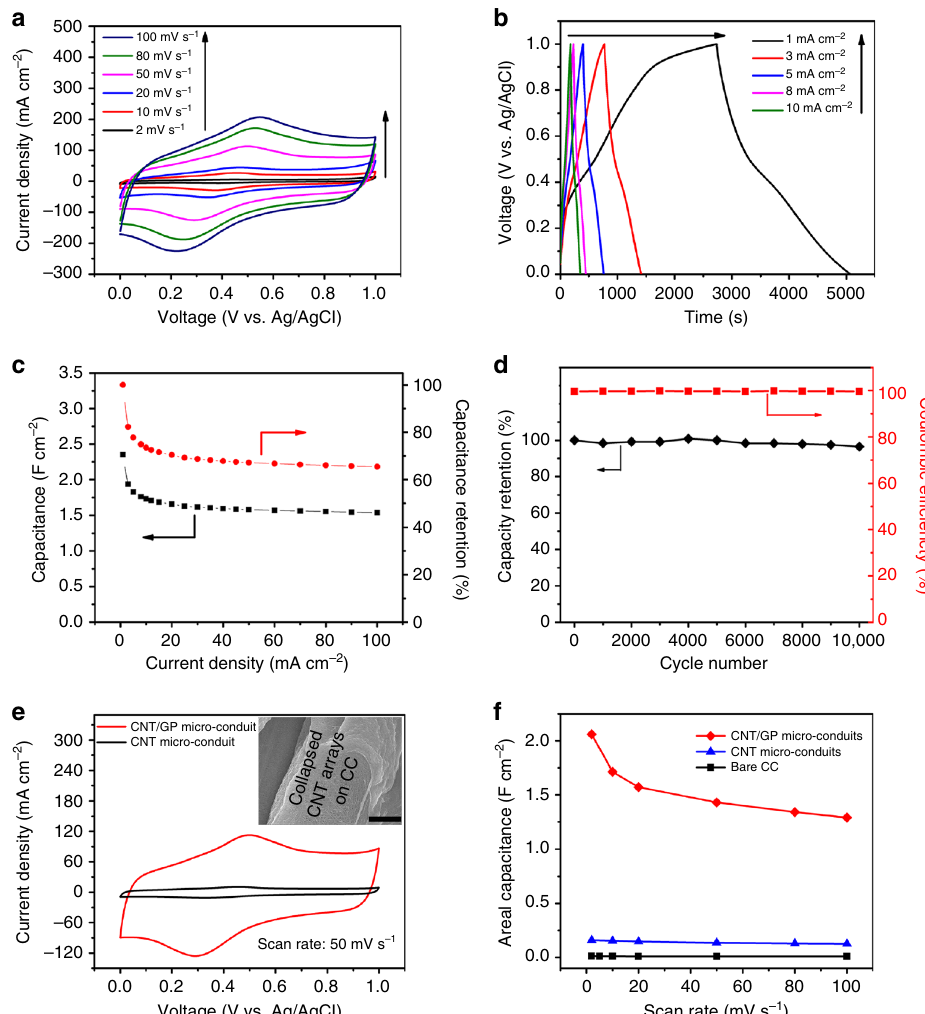
Fig. 2 Electrochemical characterization of CNT/GP micro-conduits. a CV curves of a typical CNT/GP micro-conduit electrode (GP growth time of 18 min) in a three-electrode con fi guration with 1 M H 2 SO 4 aqueous solution at scan rates from 2 to 100 mV s − 1 . b Galvanostatic charge/discharge pro fi les of the CNT/GP micro-conduit electrode at current densities from 1 to 10 mA cm − 2 . c Speci fi c capacitances and capacitance retention as functions of current densities of the CNT/GP micro-conduit electrode. d Charge/discharge cyclic stability at a current density of 60 mA cm − 2 and coulombic ef fi ciencies during the test. e Comparative CV curves of typical CNT micro-conduit and CNT/GP micro-conduit electrodes at a scan rate of 50 mV s – 1 . The inset (Scale bar: 5 μ m) shows that the bare CNT micro-conduit structure collapses and forms a matt-like structure on the CC micro- fi ber. f Comparison of areal speci fi c capacitances of bare CC, CNT micro-conduit, and CNT/GP micro-conduit electrodes at different scan rates from 2 to 100 mV s −